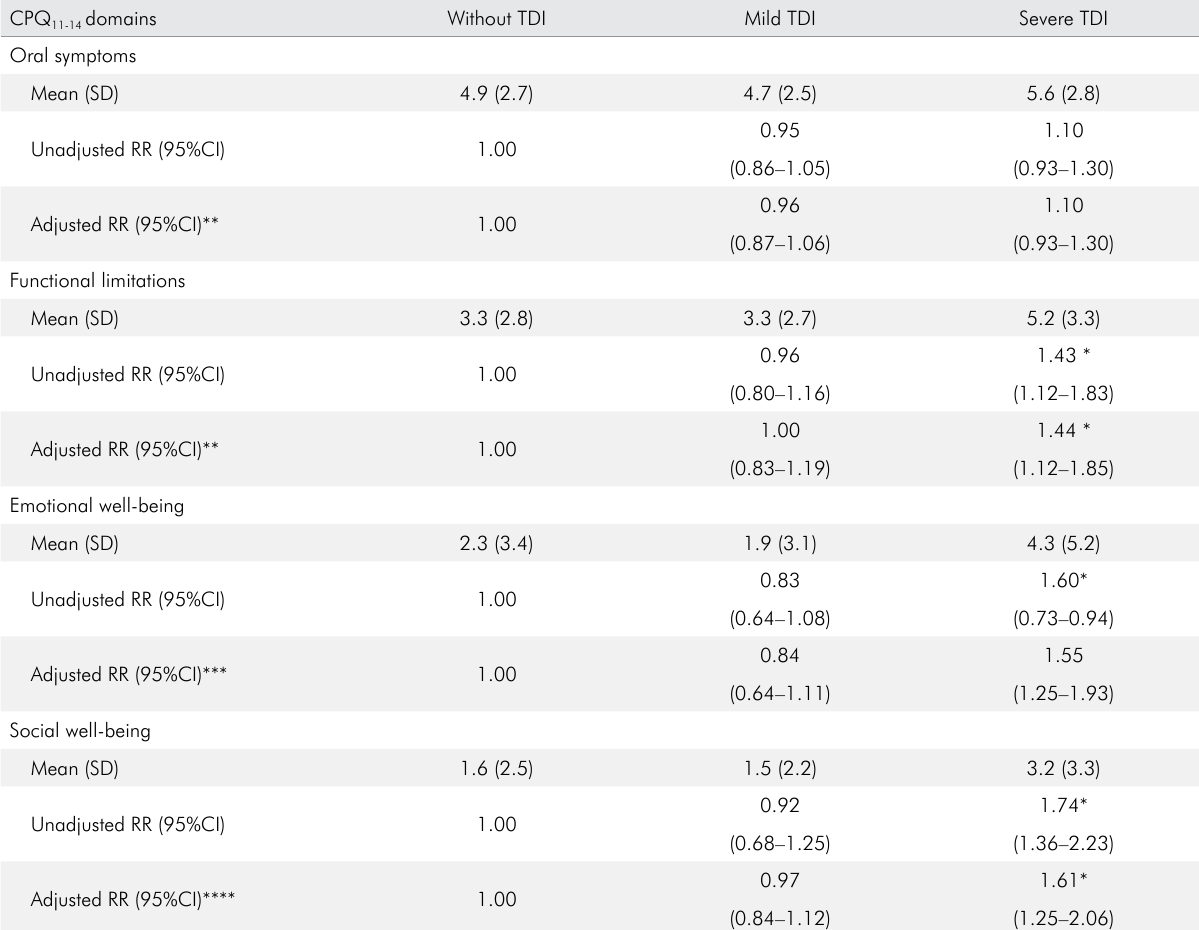
Table 4. Association of occurrence of Traumatic Dental Injuries (TDI) and the mean of the different domains of Child Perceptions Questionnaire 11-14 (CPQ ) scores using multiple multilevel Poisson 11-14